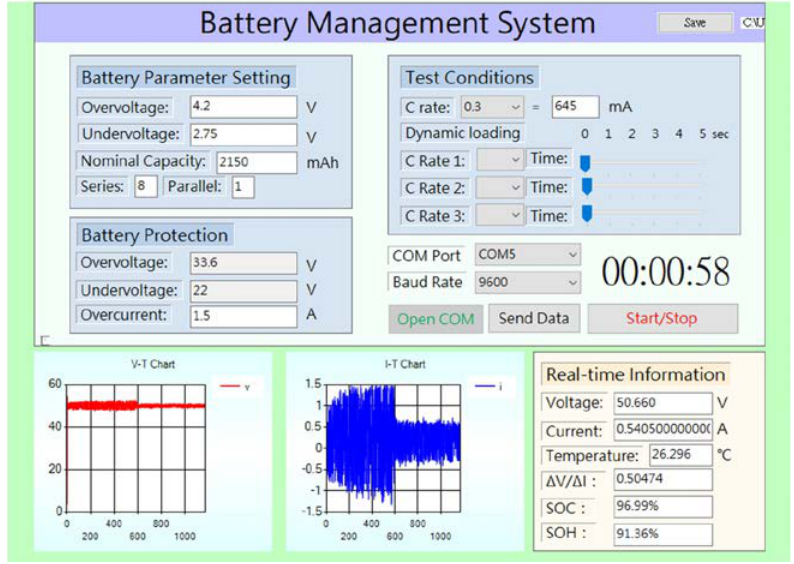
Figure 9. The proposed diagnostic system interface for the lithium battery module.